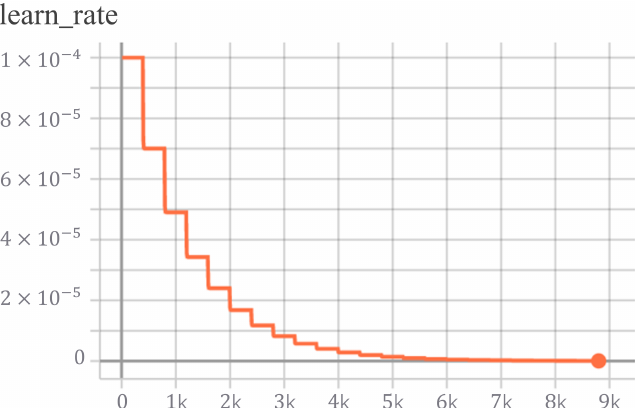
Figure 14. Learning rate